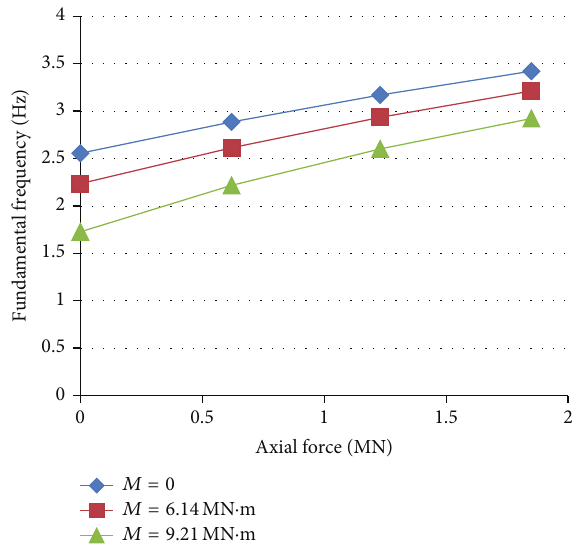
Figure 5: Variation of natural frequencies when tensile force and end moment are applied for cantilevered boundary condition.